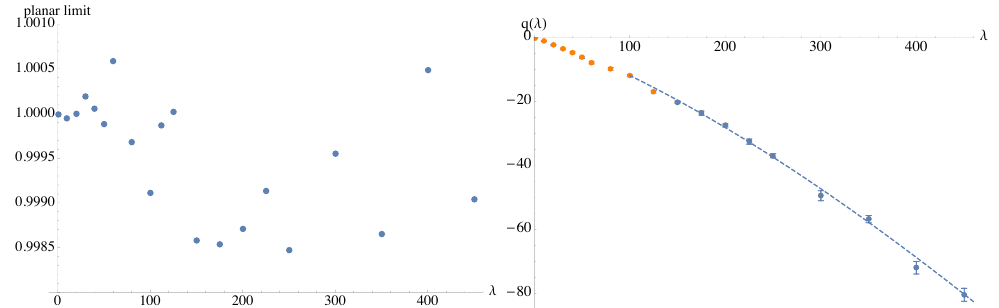
Figure 3 . Left : intercept in the large N extrapolation which should be equal to 1 due to the planar equivalence with the N = 4 SYM. The deviation is a measure of the systematic error which can be reduced at the price of increasing the maximal N used in the simulations and in the extrapolation to N = ∞ . Right: data points for the function q orb ( λ ) defined in (1.10), (3.23). Dashed line is the non-linear fit with the functional form q orb ( λ ) = C λ η (1 + a 1 λ − 1 / 2 ) . The fit is performed using data points with λ ≥ 100 which have been determined with a relative error below 3% .